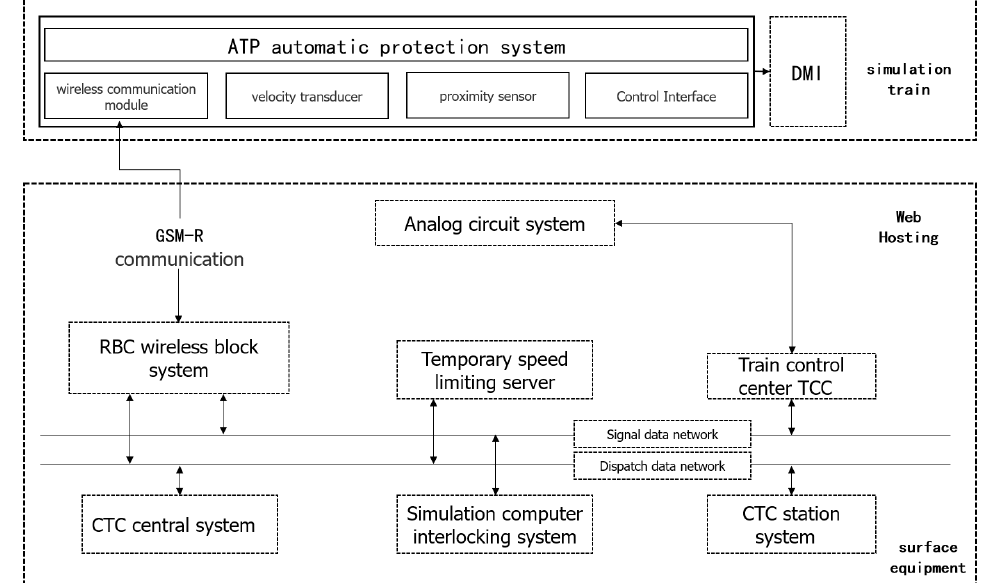
Figure 4. Traffic flow analysis of train control system.